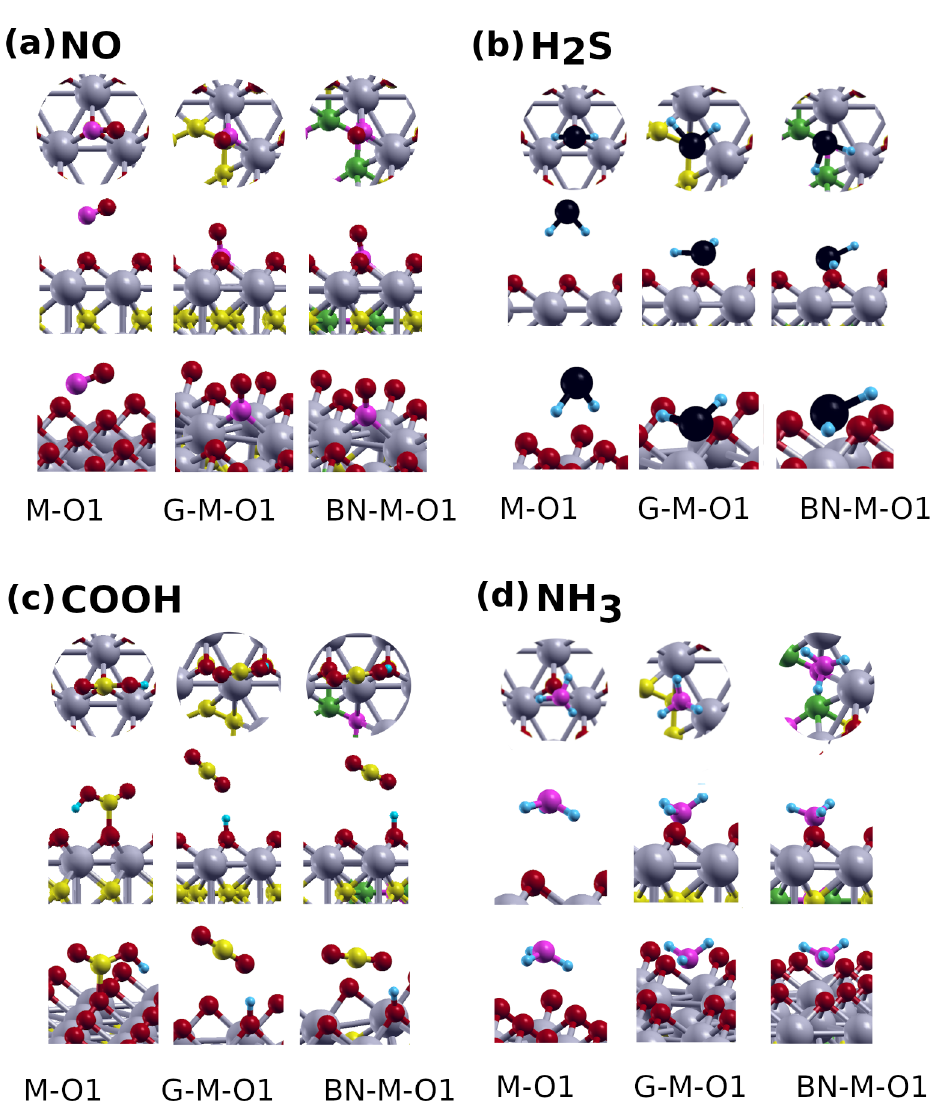
Figure 4. The optimized structures of ( a ) NO, ( b ) H 2 S, ( c ) COOH, and ( d ) NH 3 adsorbed molecules on M-O1, G-M-O1, and BN-M-O1 nanosheets in different side views. Mo, C, O, B, and N, S, and H atoms are shown in gray, yellow, red, green, pink, black, and blue, respectively. The adsorption energy E ad of the most stable configurations was calculated by Equa- tion (2). The detailed results of all the studied cases are presented in Table 2. Energies up to ∼ 2 eV indicate physisorption, while higher values indicate chemisorption [60] Calculations of E ad and ∆ Q (e) of diatomic molecules on M-O1 show that OH, NO, and CO have the largest energies, which can be explained by the polarity of oxide molecules. Thus, OH and NO are chemisorbed on M-O1 while CO, N 2 , and H 2 are physisorbed. The OH molecule stands at a distance of 1.45 Å above the M-O1 surface, with its O atom facing the sheet. For NO and CO, N and C are the atoms of contact with the sheet, respectively. As for the bond distance of NO (O-N m ), it is 2.05 Å, while for CO the distance (O-C m ) is 4.17 Å. For adsorption on G-M-O1 hybrid, all the diatomic molecules starting from the C1 position end up in the same place after structural optimization (C1 → C1). When we start the relaxation from the Mo1 position, the diatomic molecules move to C1 (Mo1 → C1) except the H 2 molecule, which stays in Mo1 (Mo1 → Mo1), (Figure